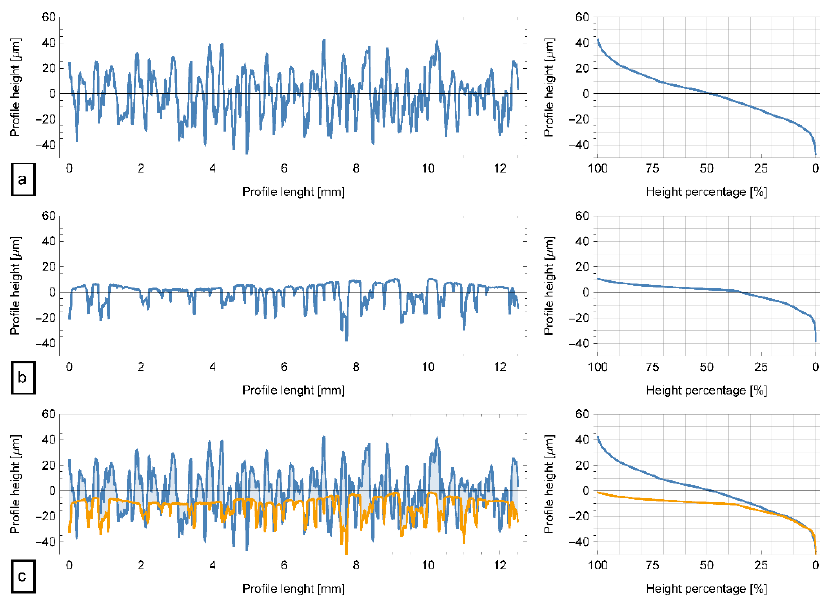
Figure 10. Roughness profile and AFC for a Ti6AL4V specimen: original profile ( a ), same surface after 24h BF ( b ), aligned profiles ( c ).